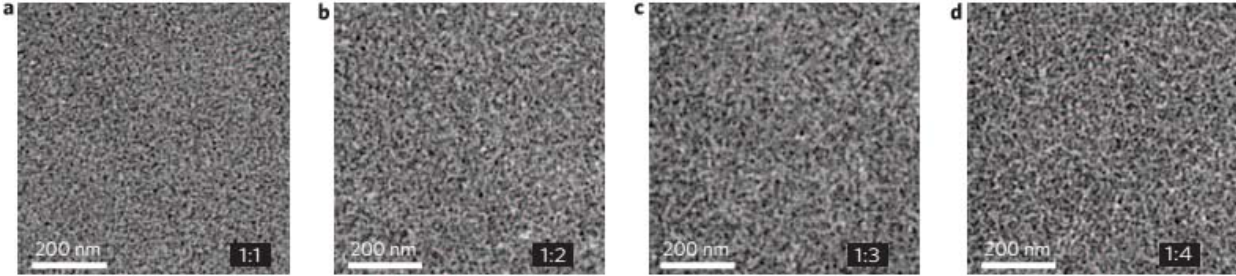
Figure 9. The effect of blending ratio on film morphology and device